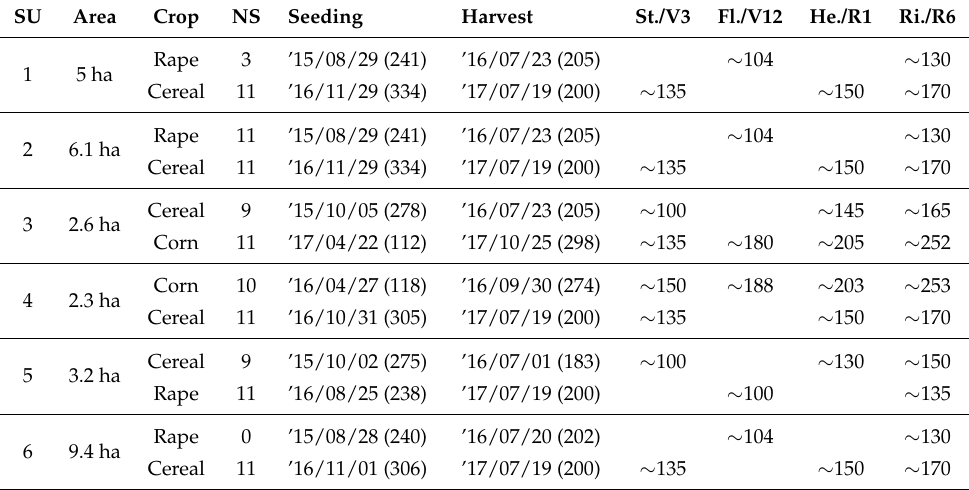
Table 1. Crop type, number of samples (NS), seeding and harvest dates (year/month/day and day of year) per year and SU. In addition, timing of phenological stages stem extension (St.), flowering (Fl.), heading (He.) and ripening (Ri.) are given in day of year for oilseed-rape (Rape) and winter cereal (Cereal) and growth stages’ three leaves (V3), 12 leaves and cob development (V12), flowering (R1) and maturity (R6) are given for